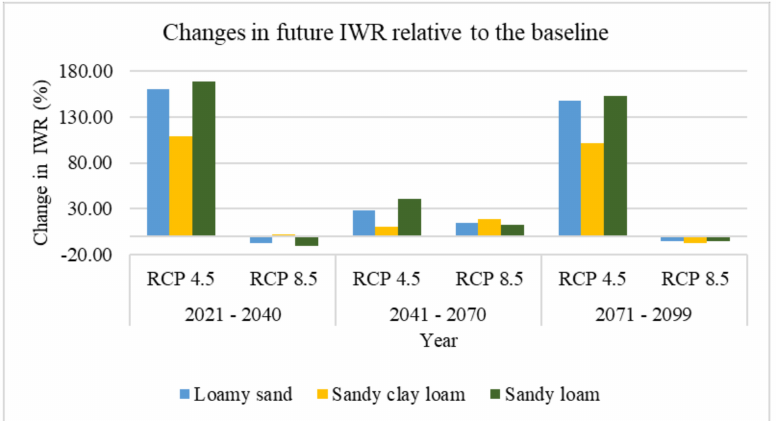
Figure 10. Temporal changes in future IWR under RCPs 4.5 and 8.5 (2021–2099) relative to the baseline